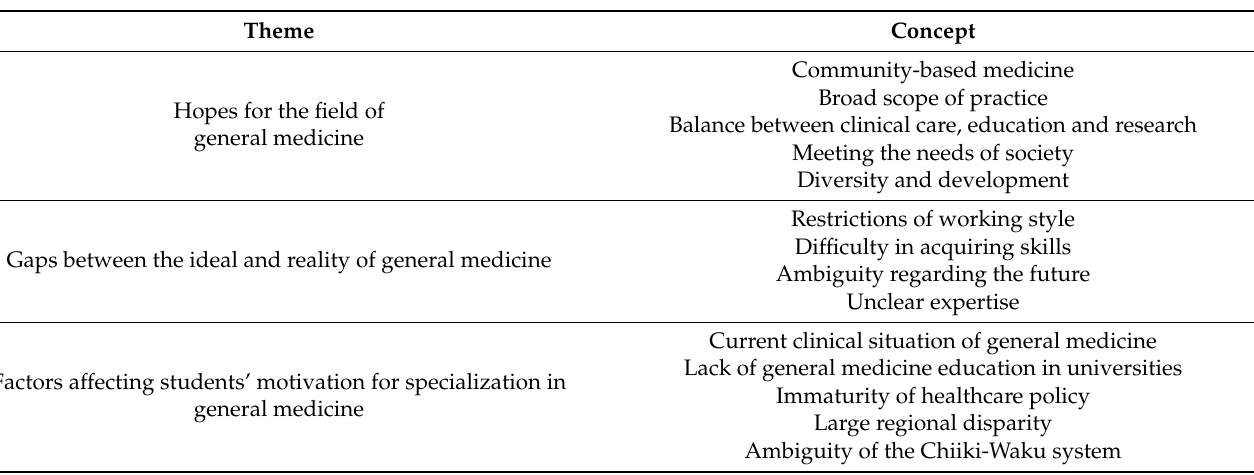
Table 2. Three themes and their concepts using thematic